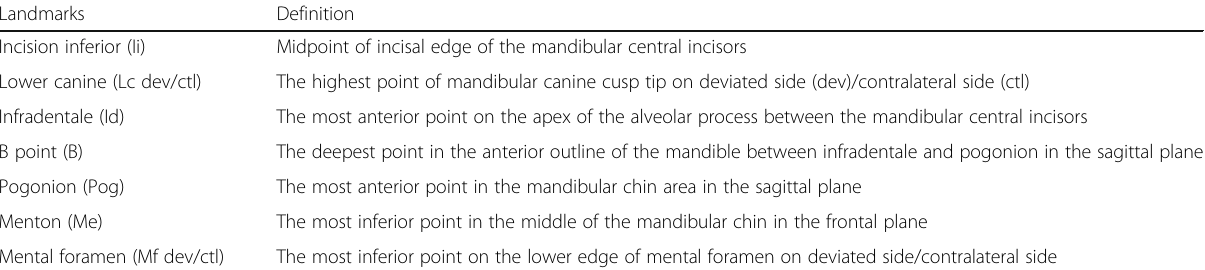
Table 1 Description of three-dimensional (3D) cone-beam CT (CBCT) landmarks in the study